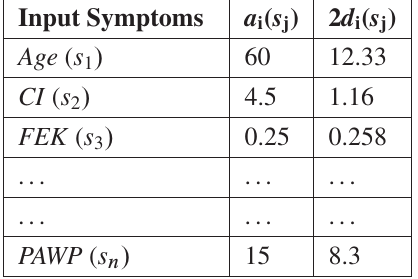
Table 3. Pre-specified a i .s j / and 2 d i .s j / values for input